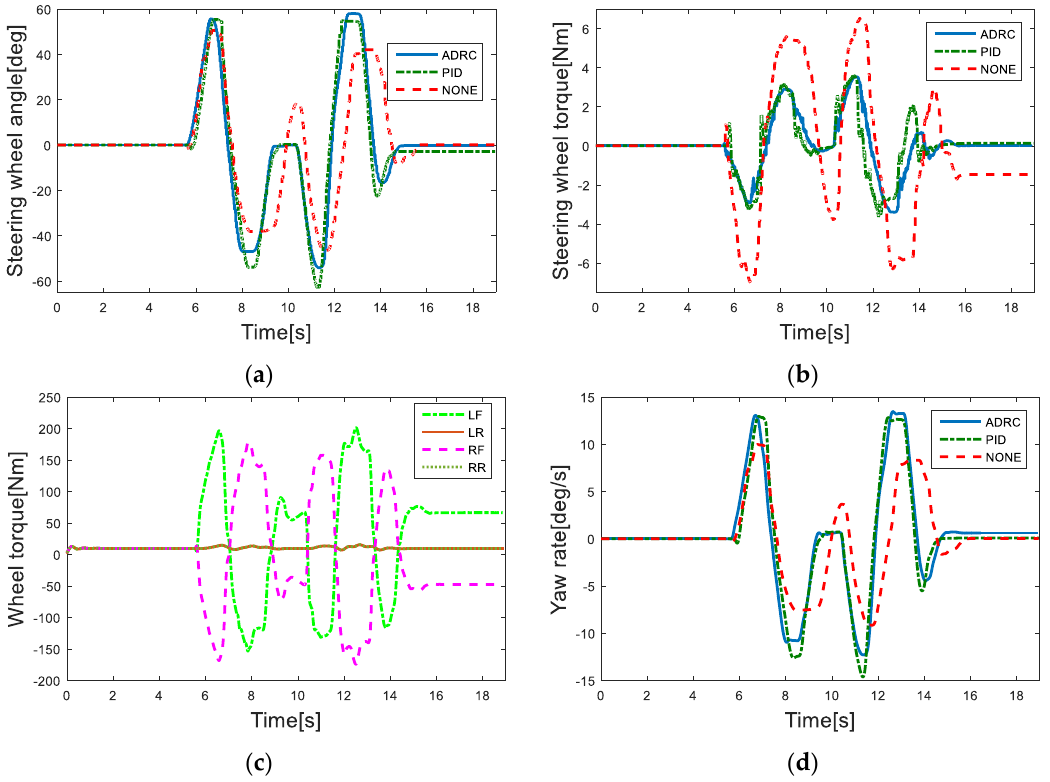
Figure 14. Simulator experiment results: ( a ) Steering wheel angle; ( b ) Steering wheel torque; ( c ) Wheel torque of ADRC controller; ( d ) Yaw rate.